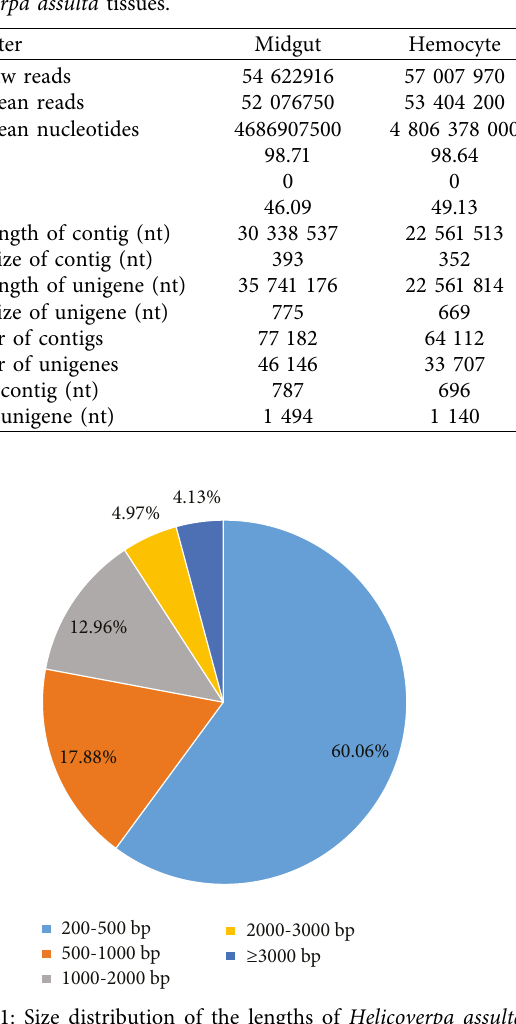
Table 1: Summary of transcriptome sequencing for different Helicoverpa assulta tissues.